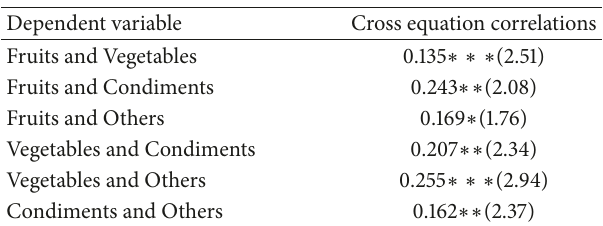
Table 6: Cross equation